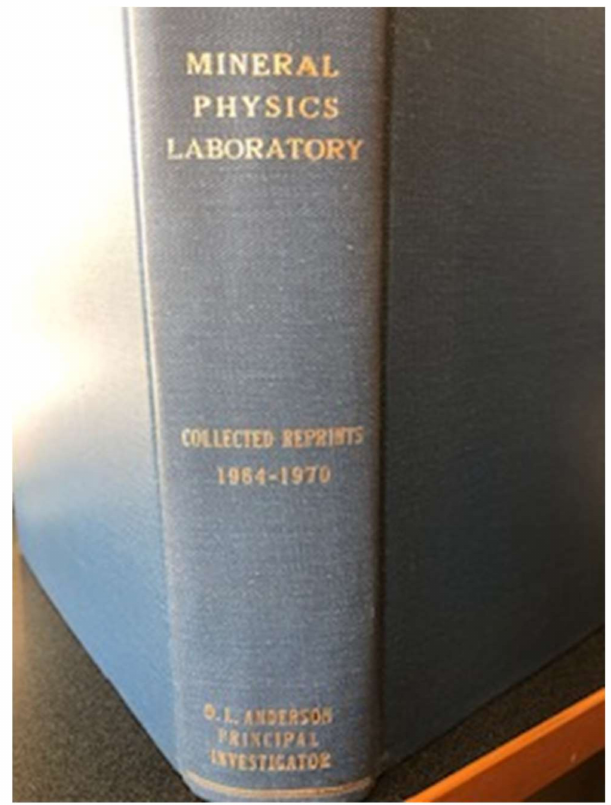
Figure 7. Collected Reprints from the mineral physics laboratory of Orson Anderson at Lamont from 1964 to